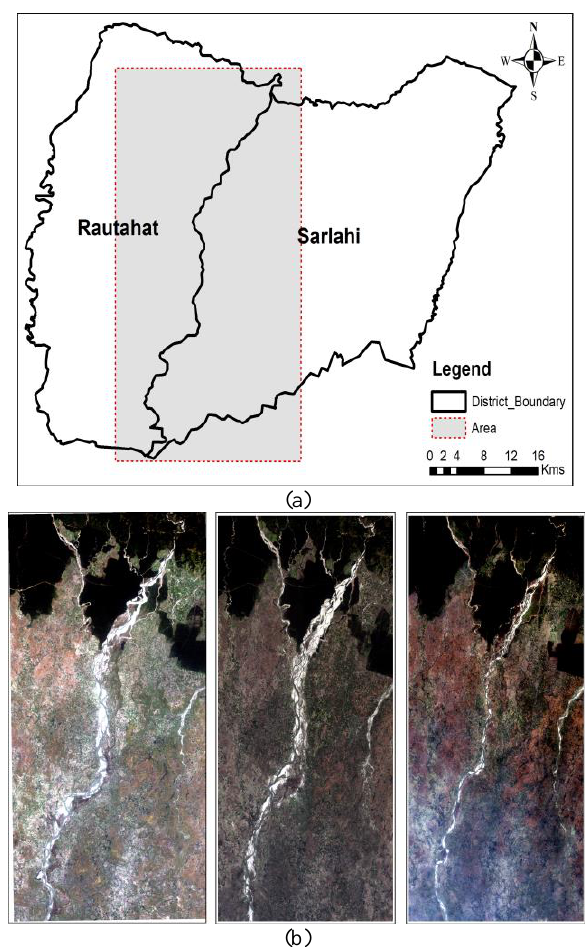
Figure 1. Map of study area showing a) district boundary and b) Natural colour composite image of the Landsat imagery for 1991, 2002 and 2016 from left to